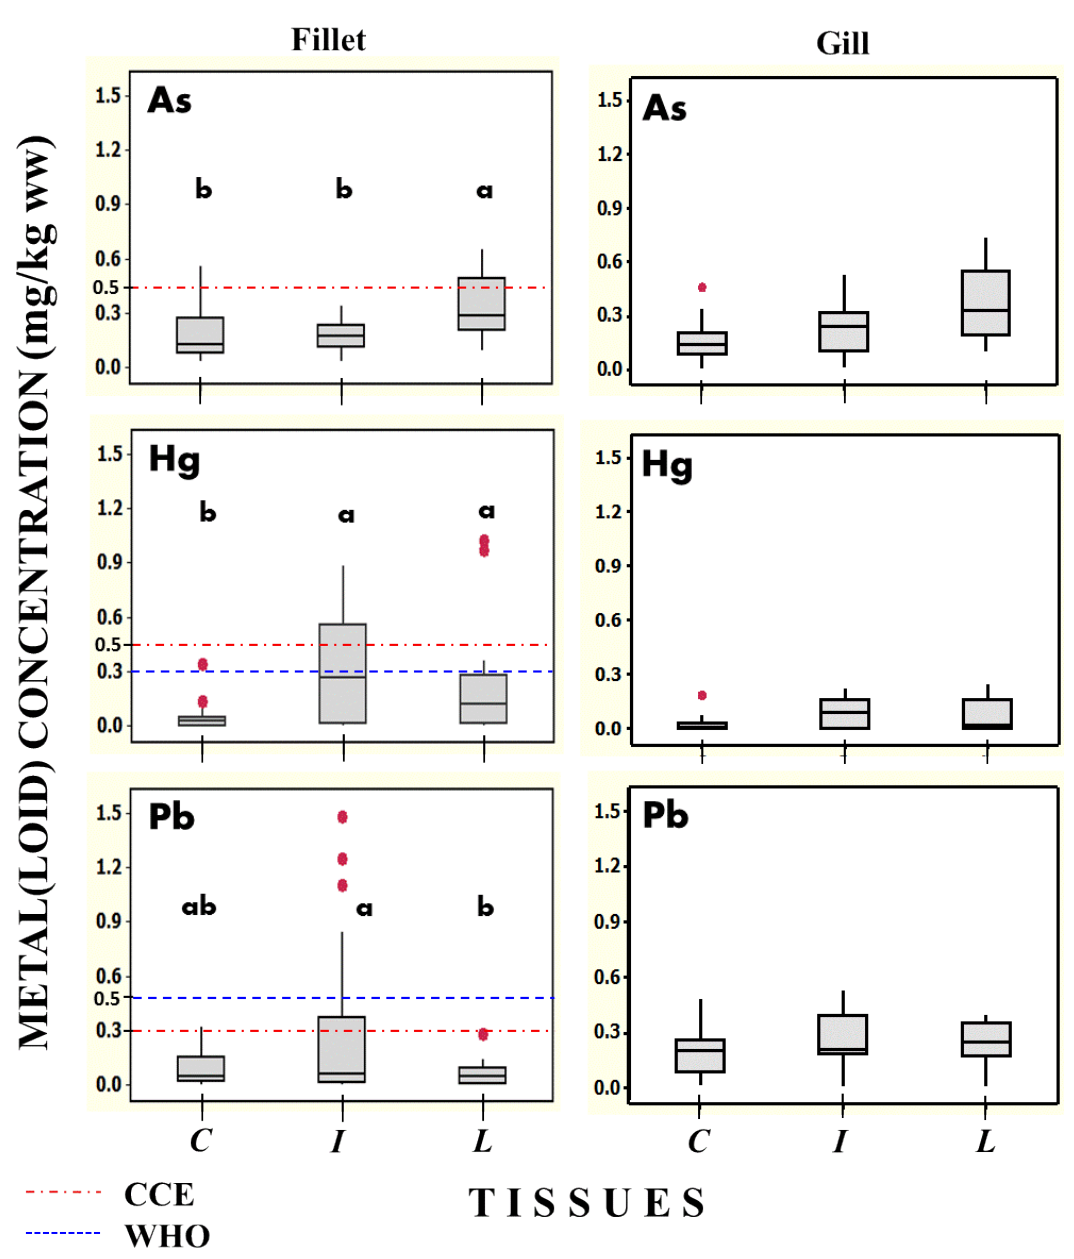
Figure 2. Box plot showing median values and 10th, 25 th, 75 th and 90 th percentiles of As, Hg and Pb concentrations in fillet (at left) of the three fish species analyzed (both sampling campaigns, n = 24). Letters C, I, L means Cyprinus, Ictalurus, Lepomis . Letters a or b for the species represent significant differences between the observed concentration values for the given element ( p < 0.05), after ANOVA analysis followed by Tukey post hoc test. Horizontal dotted lines show the guidance levels in wet weight for human consumption reported in CCE and WHO/FAO (see text). Box plot at right shows concentrations of As, Hg and Pb in